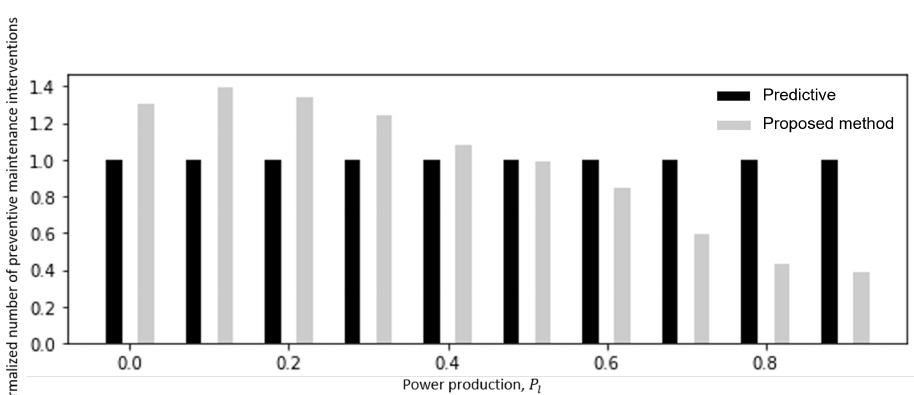
Figure 6. Number of maintenance interventions at different RUL values, with C = 3.